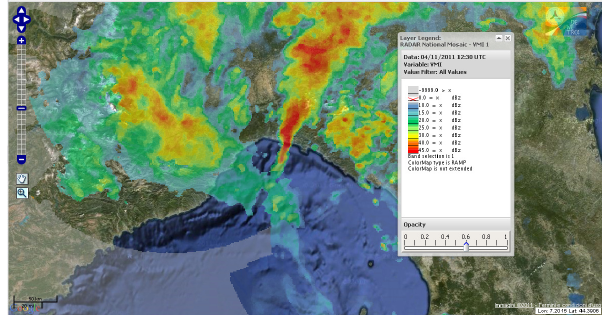
Figure 3. Finger-like isolated auto-regenerating MCS in front of the Genoa coast on 2 Fig. 3. Finger-like isolated auto-regenerating MCS in front of the November 4th at 12:30 UTC (Maximum Vertical Reflectivity, RC). 3 Genoa coast on 4 November at 12:30UTC (Maximum Vertical Re- flectivity, RC).